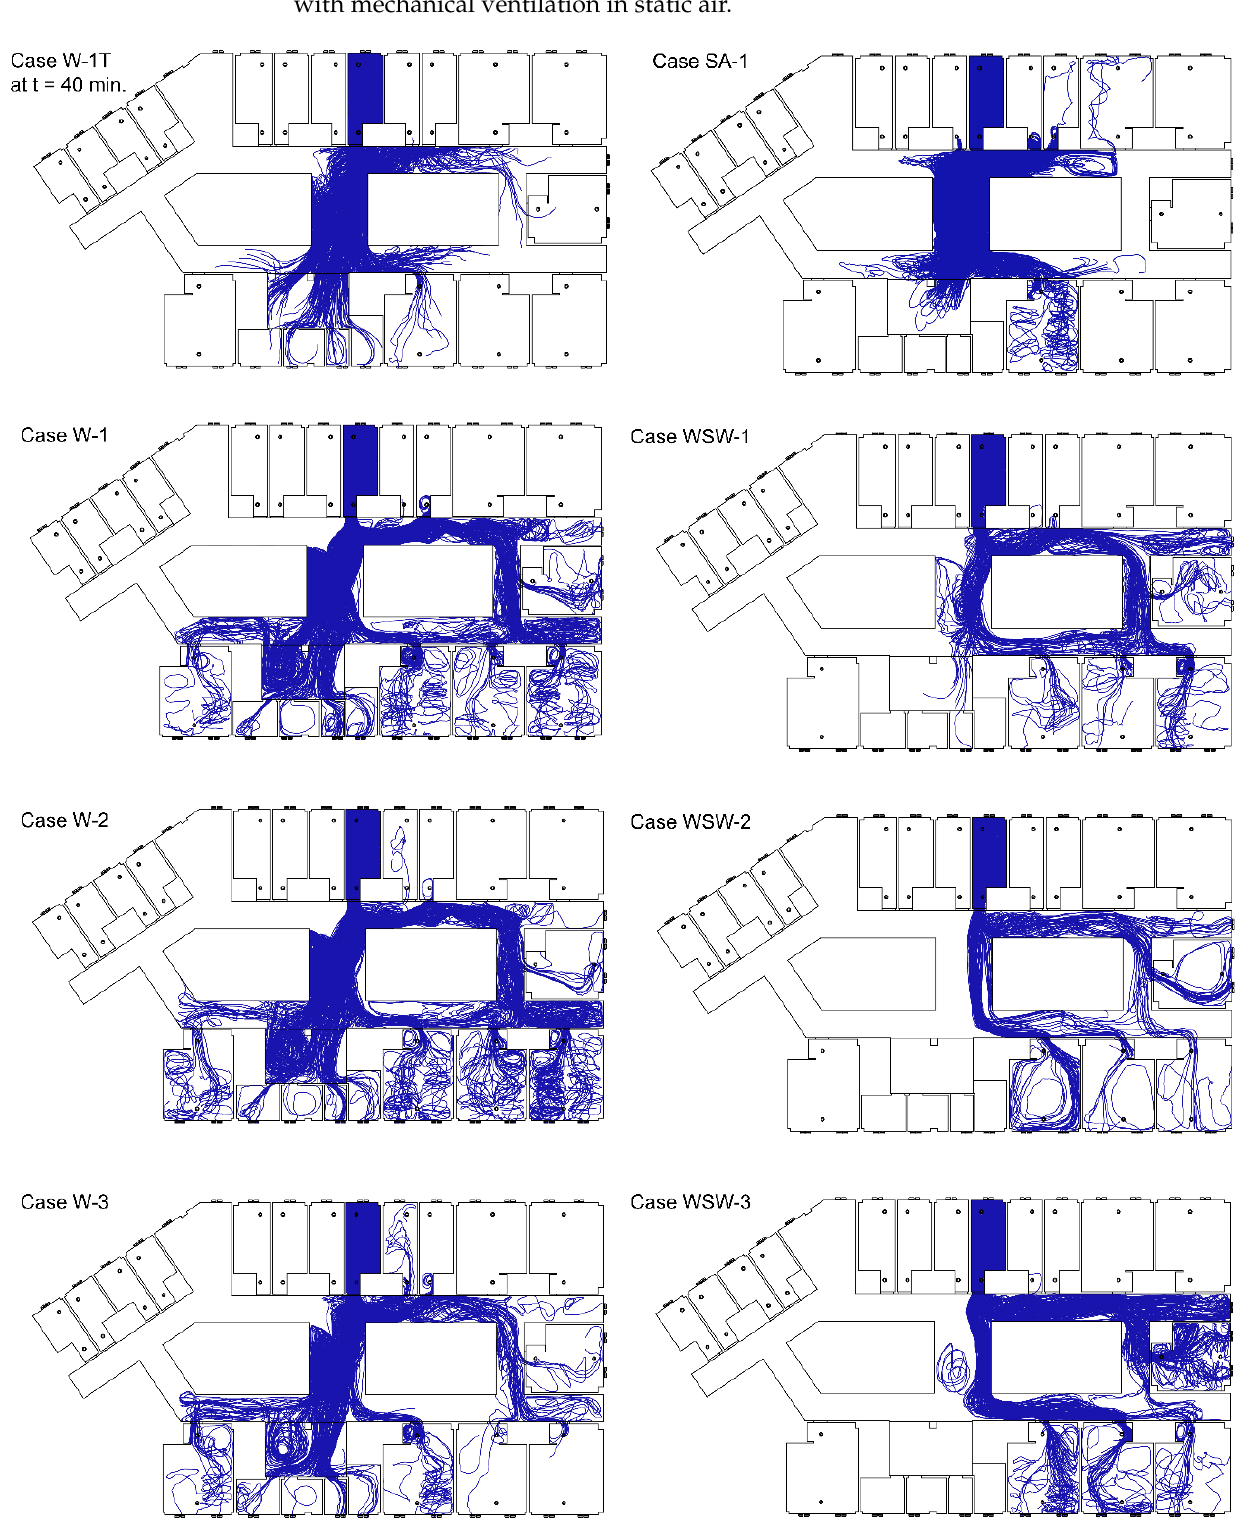
Figure 4. Trajectories of particles emitted from breathing. With the pressure difference from the wind, droplets moved longer distances. In the case of the west wind, droplets dispersed mainly to corridor (d) and moved to the